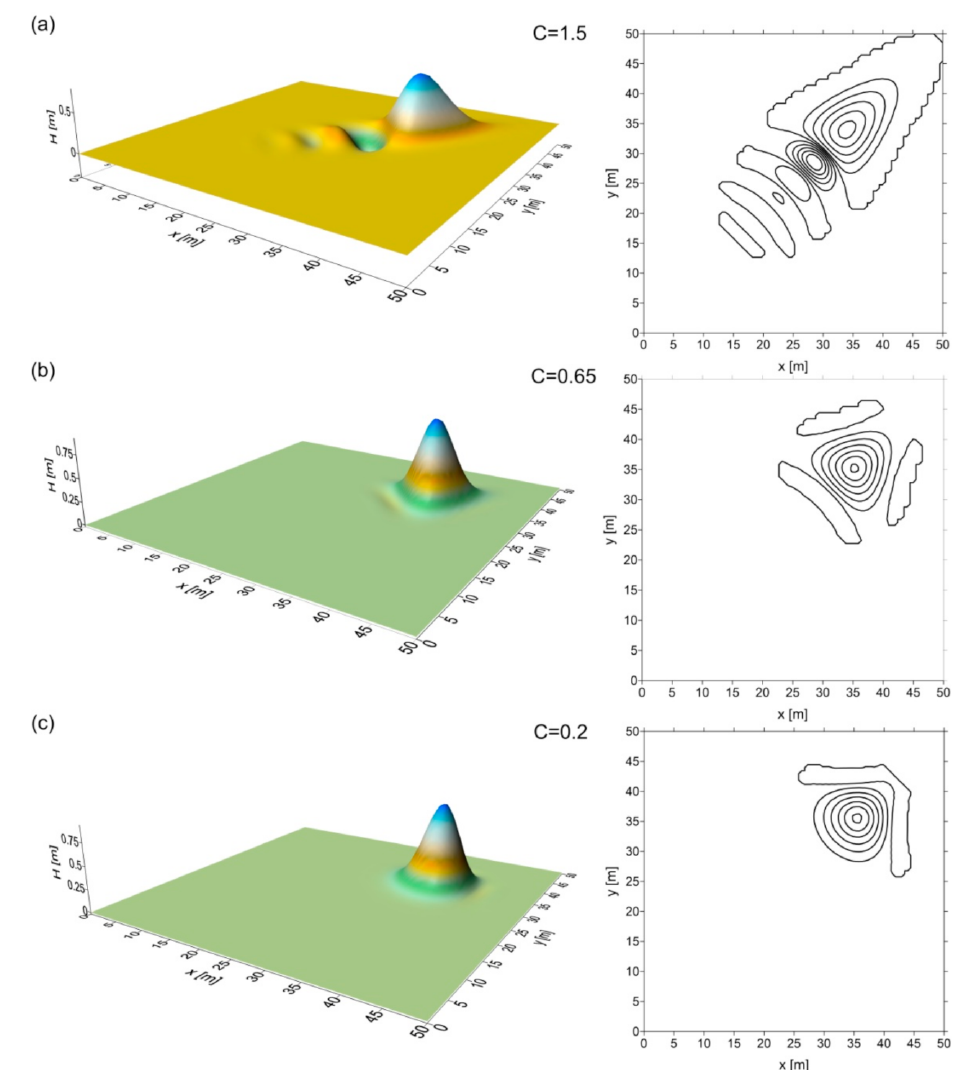
Figure 11. Solution obtained using the 6NI mesh with θ = 1/2 and α = 1/3 for various values of the Courant number: ( a ) C = 1.5; ( b ) C = 0.65; ( c ) C =